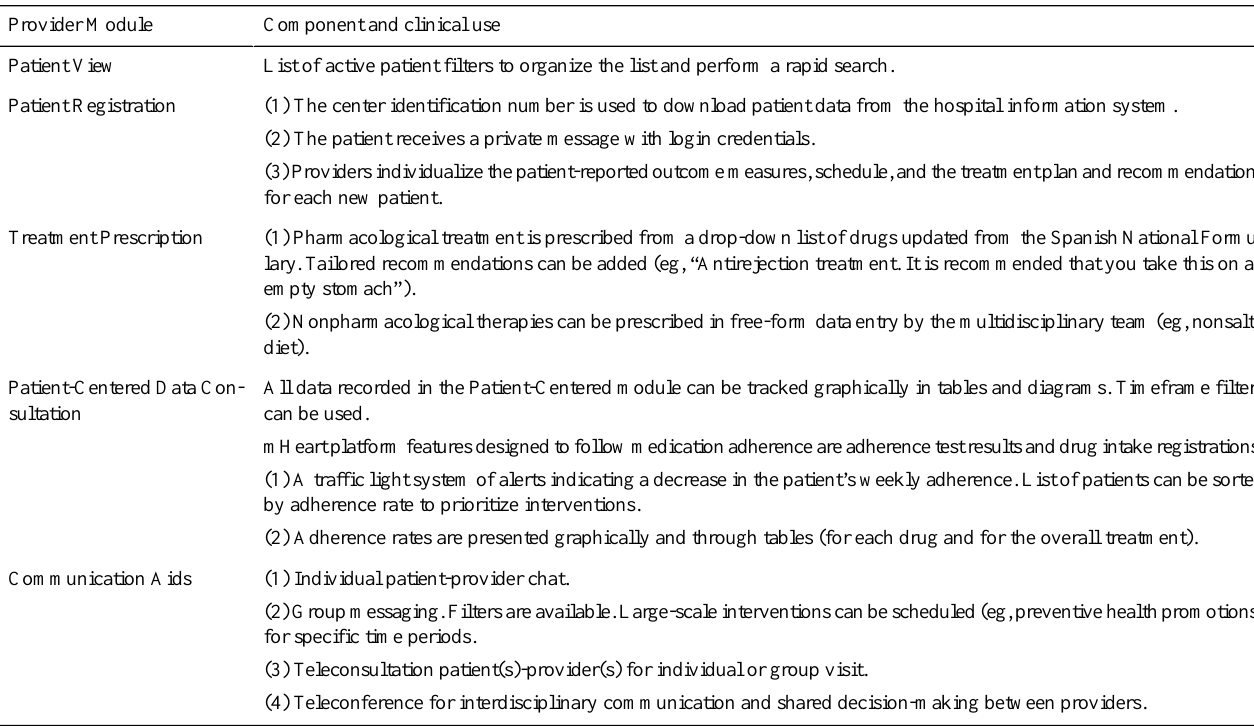
Table 5. mHeart professional profile modules, components, and clinical use. Component and clinical useProvider